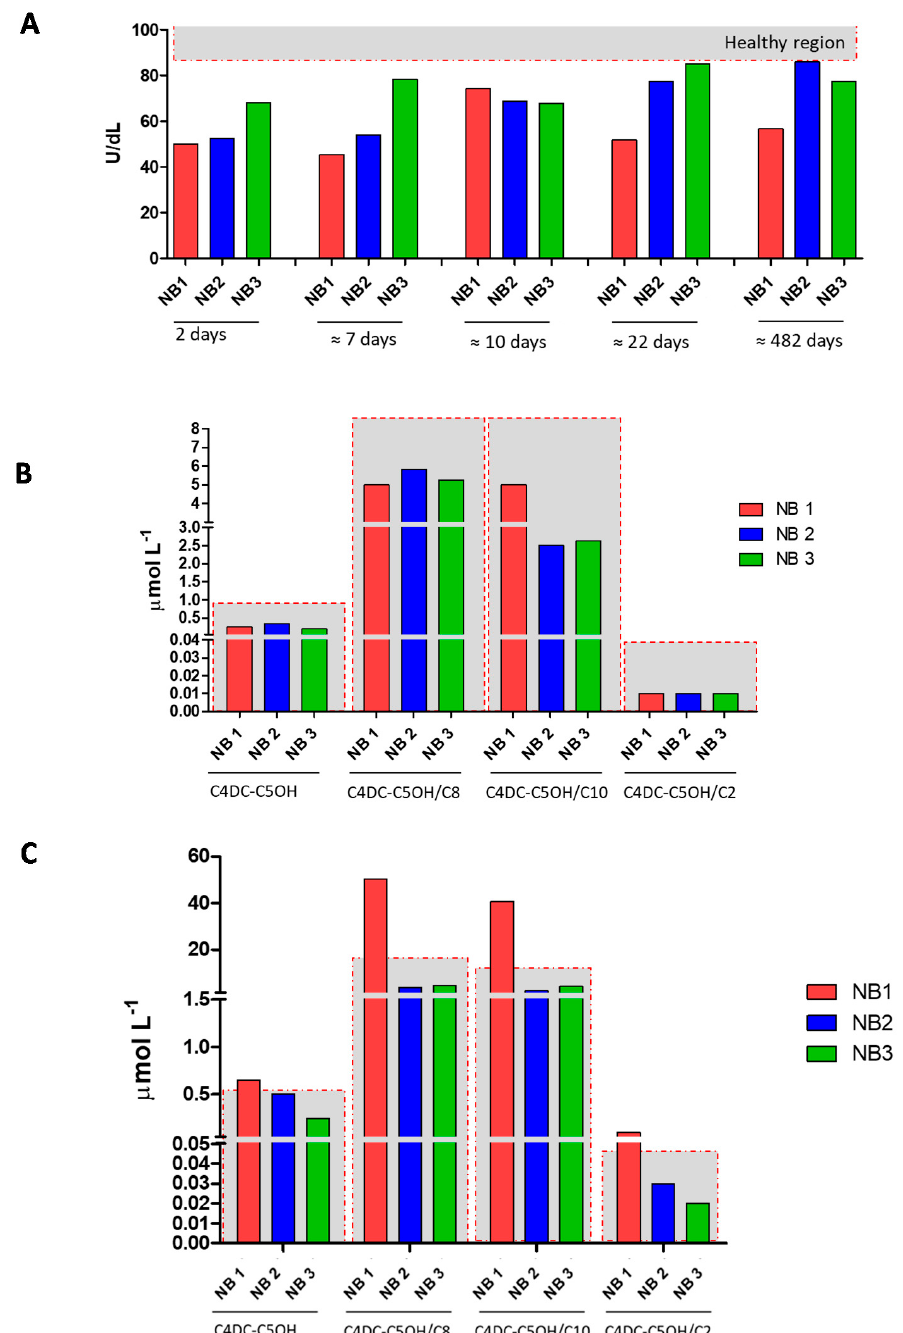
Figure 3. Panel A shows BTD activity measured in dried blood spot (DBS) samples from the newborn subject of the case report (NB1 in red) and the other two newborns with partial BTD deficiency (NB2 and NB3 in blue and green, respectively) at 2, 7, 10, 22, and 482 days of life. Panel B shows the levels of C4DC-C5OH and its ratios C4DC-C5OH/C2, C4DC-C5OH/C8, and C4DC-C5OH/C10 for NB1, NB2, and NB3 at 2 days of life. Panel C shows the levels of C4DC-C5OH and its ratios C4DC-C5OH/C2, C4DC-C5OH/C8, and C4DC-C5OH/C10 for NB1, NB2, and NB3 at about 482 days of life. The samples inside the gray region are considered within the reference limits, while samples falling outside the gray region and marked with red asterisks are outside of the reference limits for newborn screening.